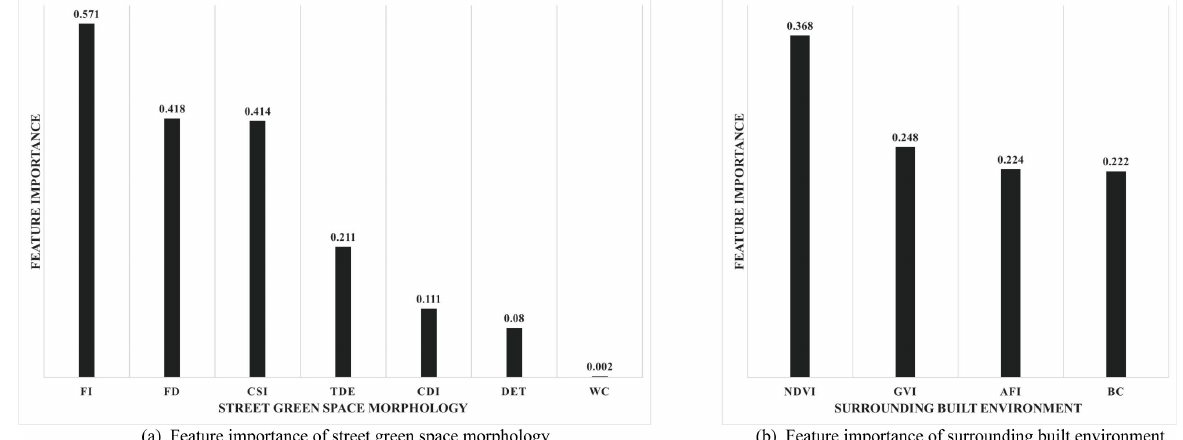
Figure 6. Comparison chart of feature importance ranking for XGBoost prediction task.